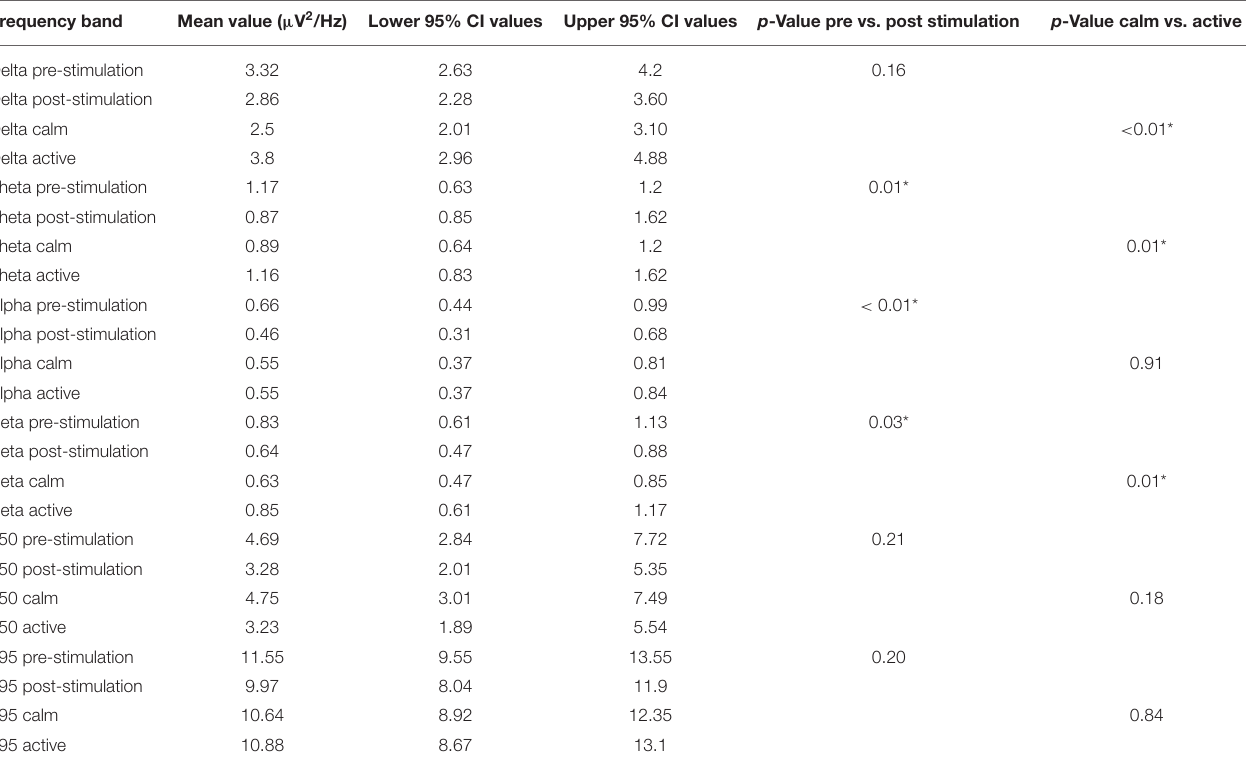
TABLE 3 | Pooled power spectral analysis per frequency band with upper and lower confidence intervals for the pre- and post-stimulation periods and for the calm vs. active states. Frequency